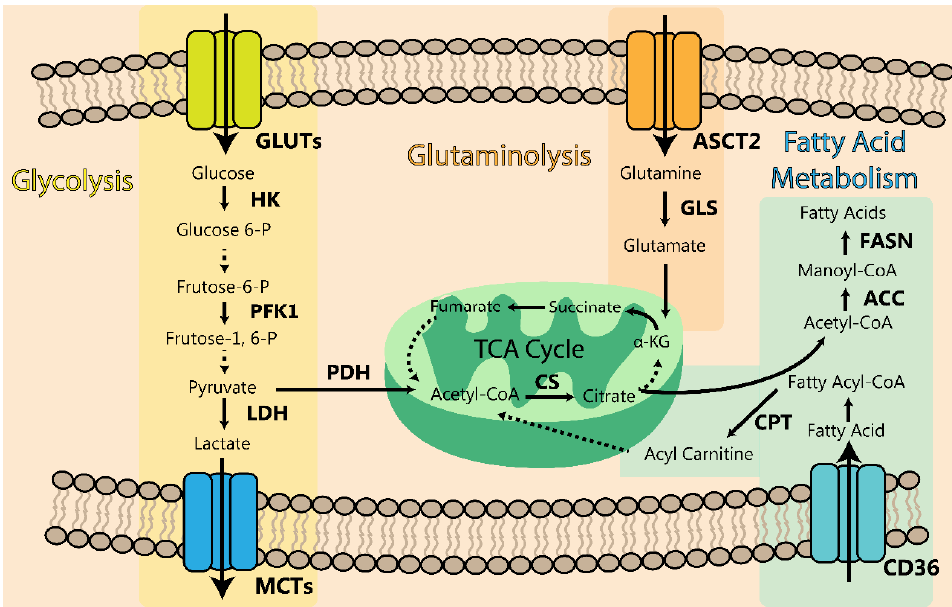
Figure 7. Schematic representation of the discussed metabolic pathways in PDAC. The glycolytic pathway (yellow shade), glutaminolysis (orange shade), and the fatty acid metabolism (blue shade) are represented. The enzymes and transporters (bold) are the key intermediated targets which can be envisaged for new promising therapeutic strategies. Dashed arrows indicate more reactions not explored in the review. Legend: glucose transporters (GLUT1 and GLUT3), hexokinase (HK), phosphofructokinase 1 (PFK1), pyruvate dehydrogenase (PHD), lactate dehydrogenase (LDH), monocarboxylate transporters (MCT4 and MCT1), fatty acid transporter CD36, fatty-acid synthase (FASN), acetyl-CoA carboxylase (ACC), carnitine palmitoyl transferase (CPT), citrate synthetase (CS), ASCT2 (glutamine transporter) and glutaminase (GLS).